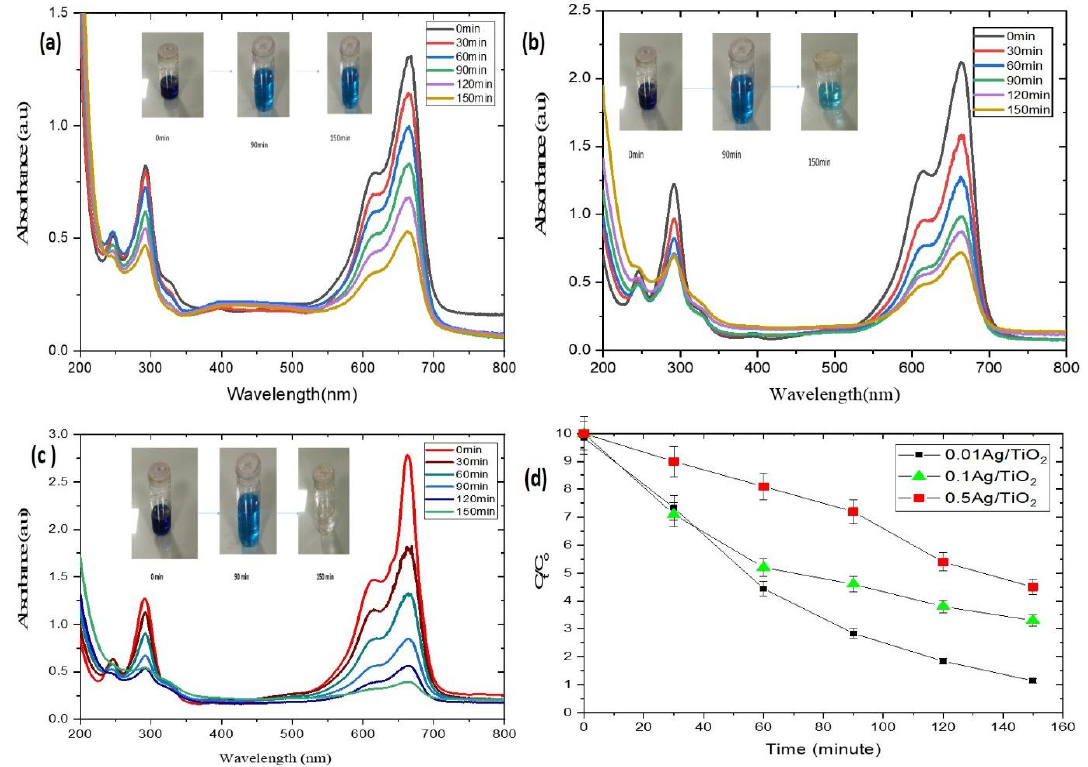
Figure 7. ( a ) The UV visible spectrum of methylene blue in the presence of 0.5 Ag/TiO 2 composite. ( b ) In the presence of 0.1 Ag/TiO 2 composite, methylene blue’s UV spectrum. ( c ) The UV visible spectrum of MB in the presence of 0.01 Ag/TiO 2 composite. ( d ) The comparison graph of 0.5 Ag/TiO 2 , 0.1 Ag/TiO 2 , and 0.01 Ag/TiO 2 composites.